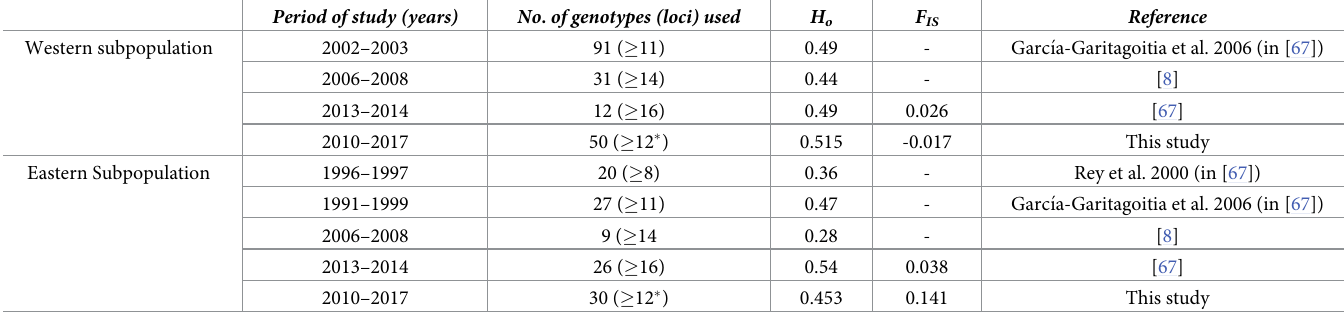
Table 2. Summary of the genetic diversity of the two Cantabrian brown bear subpopulations obtained from different